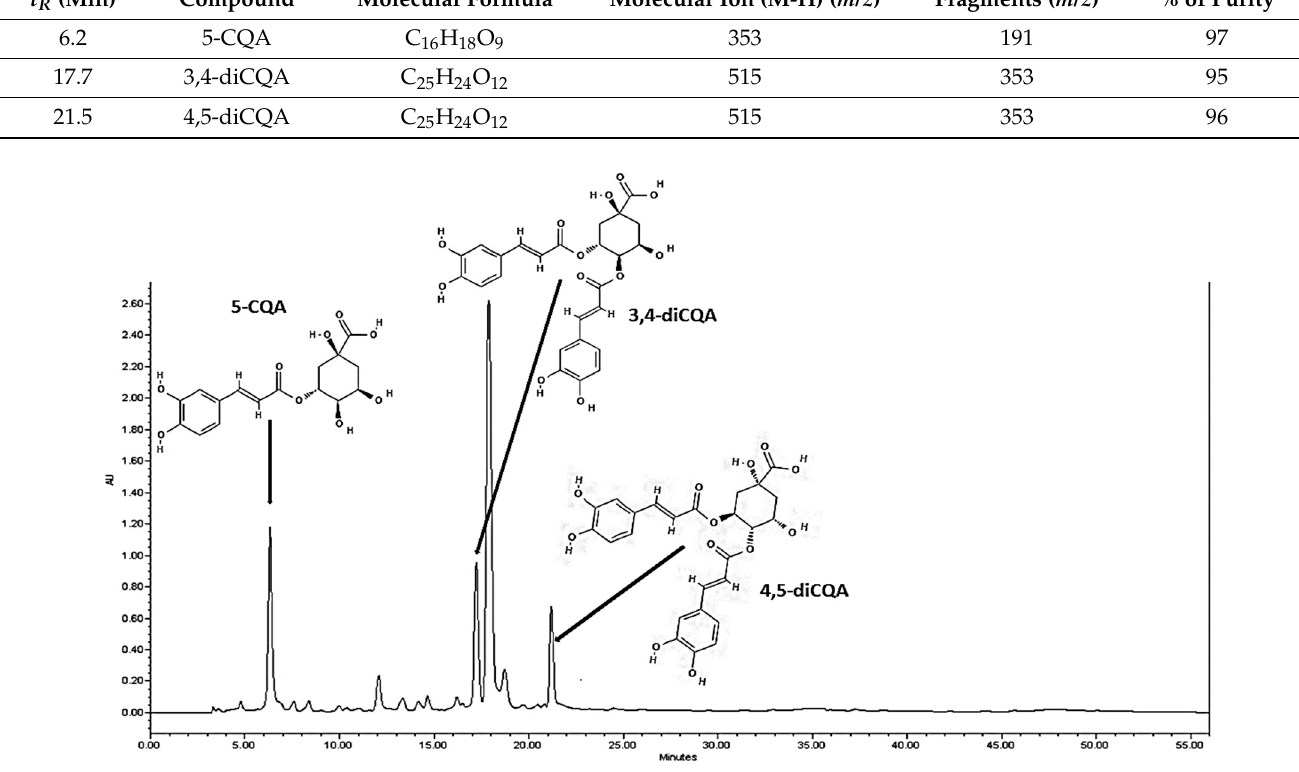
Figure 2. Chromatogram of CQA-derivatives from PSP and detected 320 nm. Table 1. CQA-derivatives in PSP identified by mass spectrometry (HPLC-MS)